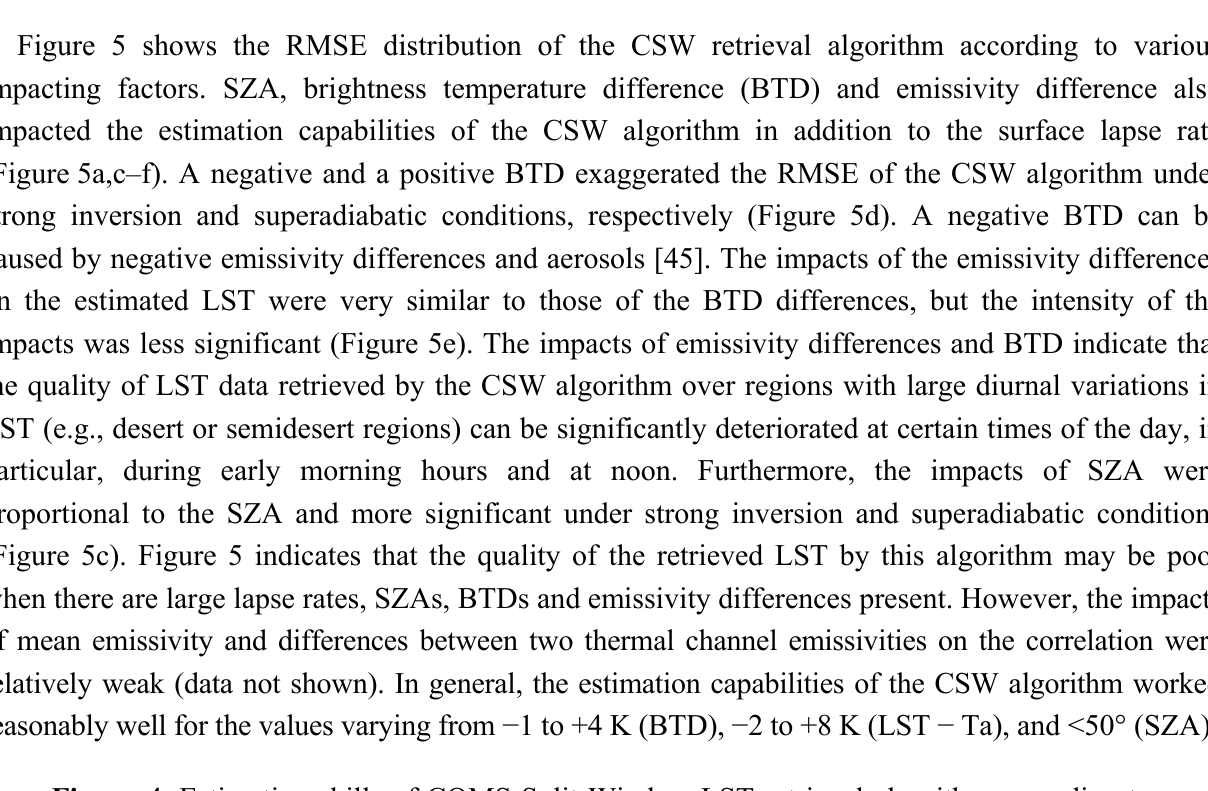
Figure 4. Estimation skills of COMS Split-Window LST retrieval algorithm according to the difference between LST and air